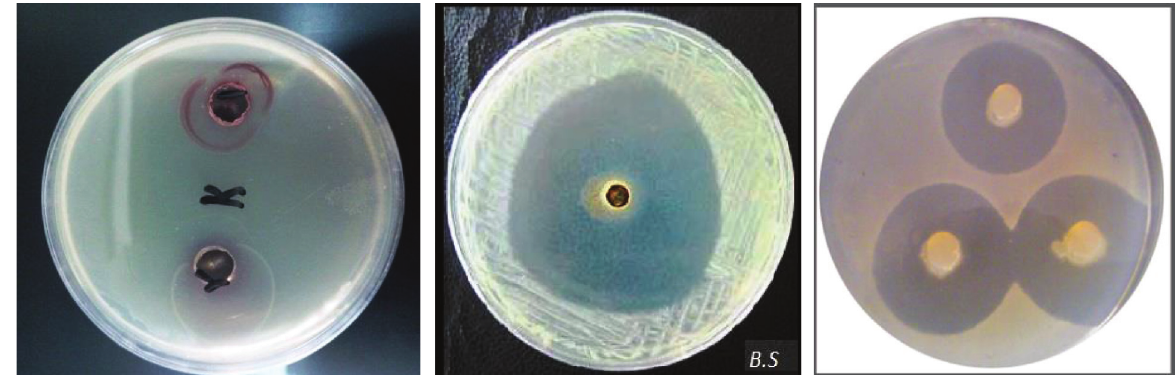
Figure 2: Images of the culture plates seeded with Escherichia coli (ATCC 11775), Klebsiella pneumoniae ATCC 13883, Staphylococcus aureus ATCC 33591, and Bacillus subtilis ATCC 605 so that the inhibition zone created by the samples can be observed.